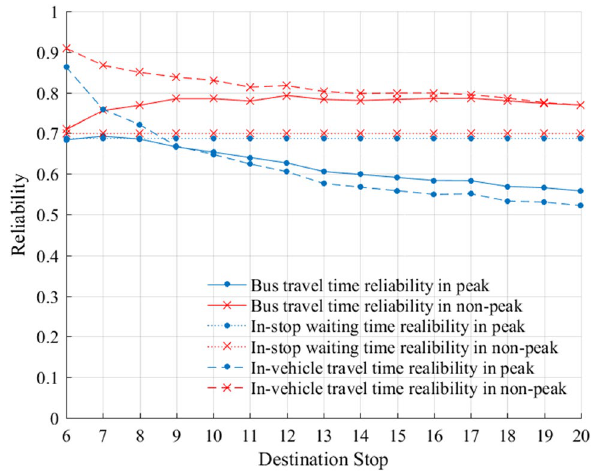
Fig. 6 Bus travel time reliability from 5th Stop to different other stops